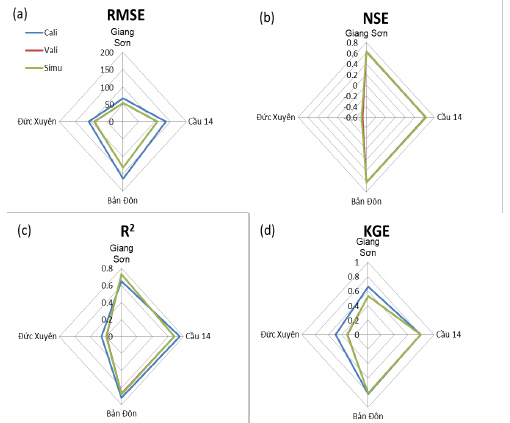
Fig. 11: Visualization maps of simulation results (i.e. runo(cid:27), river (cid:29)ow, soil moitrue, evaporation, etc ...) showing on